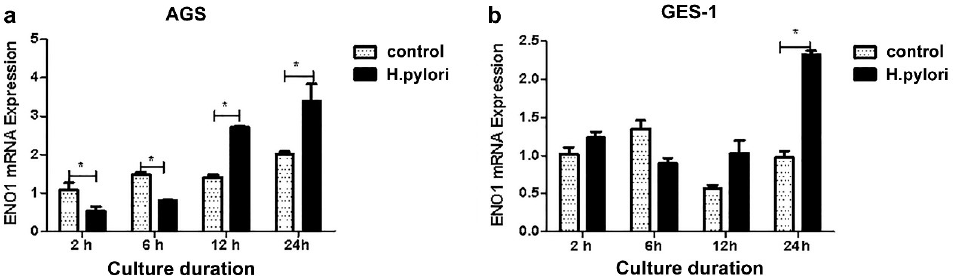
Figure 3. ENO1 mRNA levels in the AGS ( a ) and the GES-1 ( b ) cells co-cultured with H. pylori for various times. *, p < 0.05.